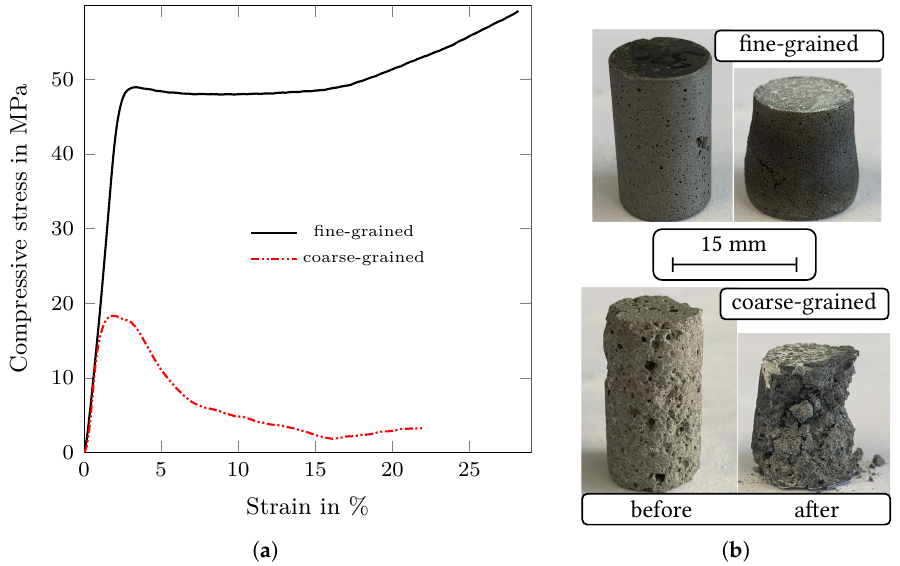
Figure 11. ( a ) Results of compression tests at a temperature of 1300°C performed on the fine-grained and coarse-grained composites and ( b ) photographs of the corresponding specimens before and after the